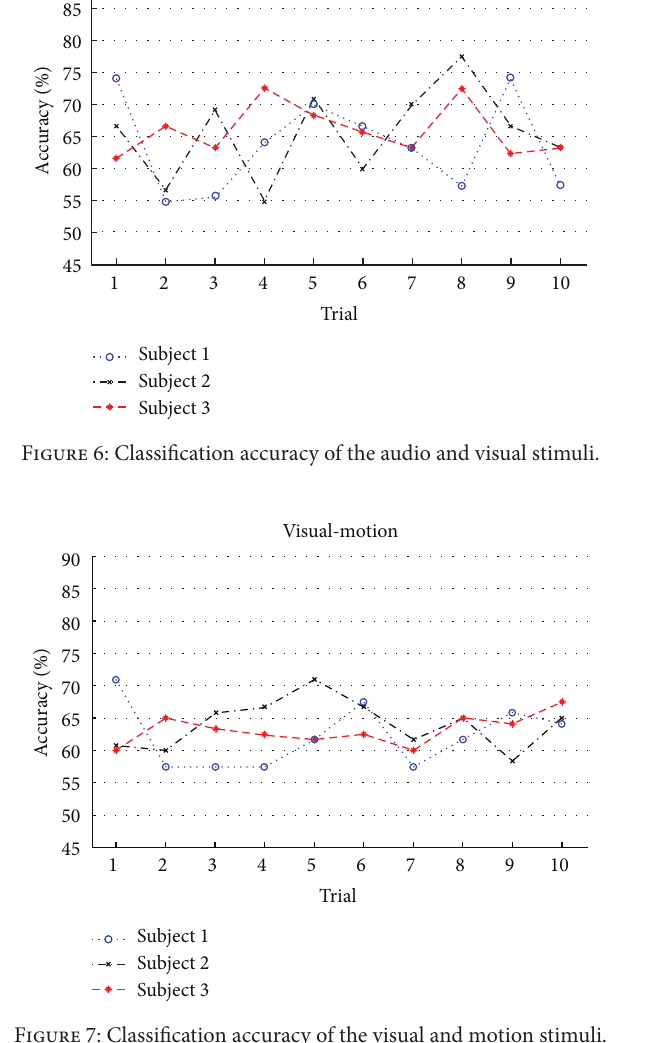
focused on the summation of the MSEs in 1 s. Therefore, the advantage of EEG was not well presented.